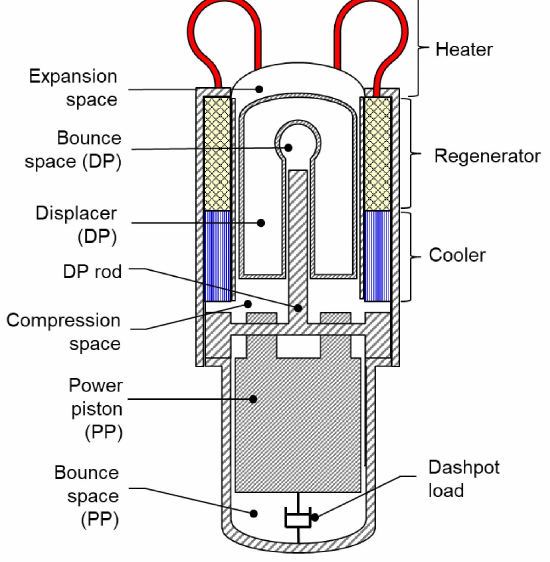
Figure 5. Schematic of the RE-1000 engine (built by NASA). Table 9. Design parameters and operating conditions of the RE-1000 engine for the #1011